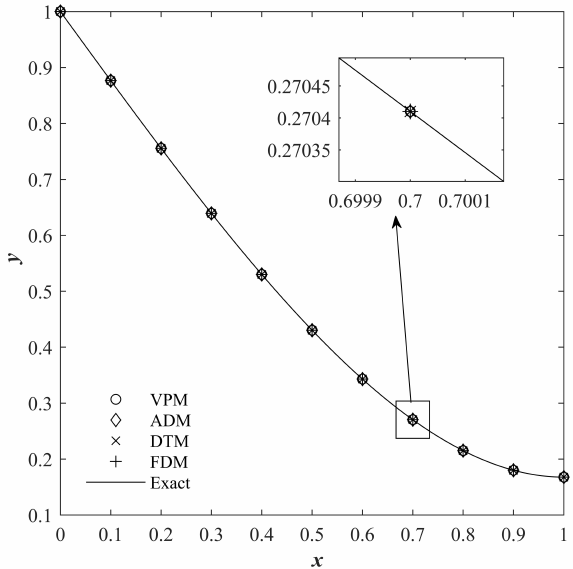
Fig. 1: Comparison of the solutions to equation (18) using all